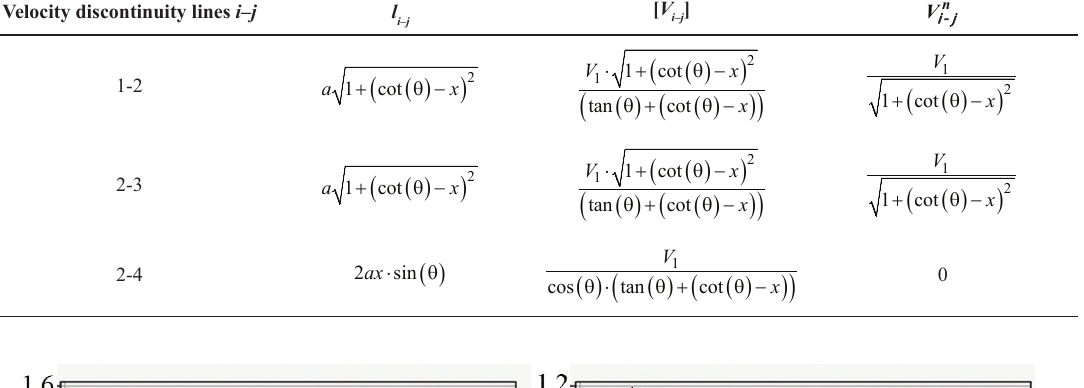
Table 1. The lines of discontinuity and sliding velocities for a 2 θ -Segal die.